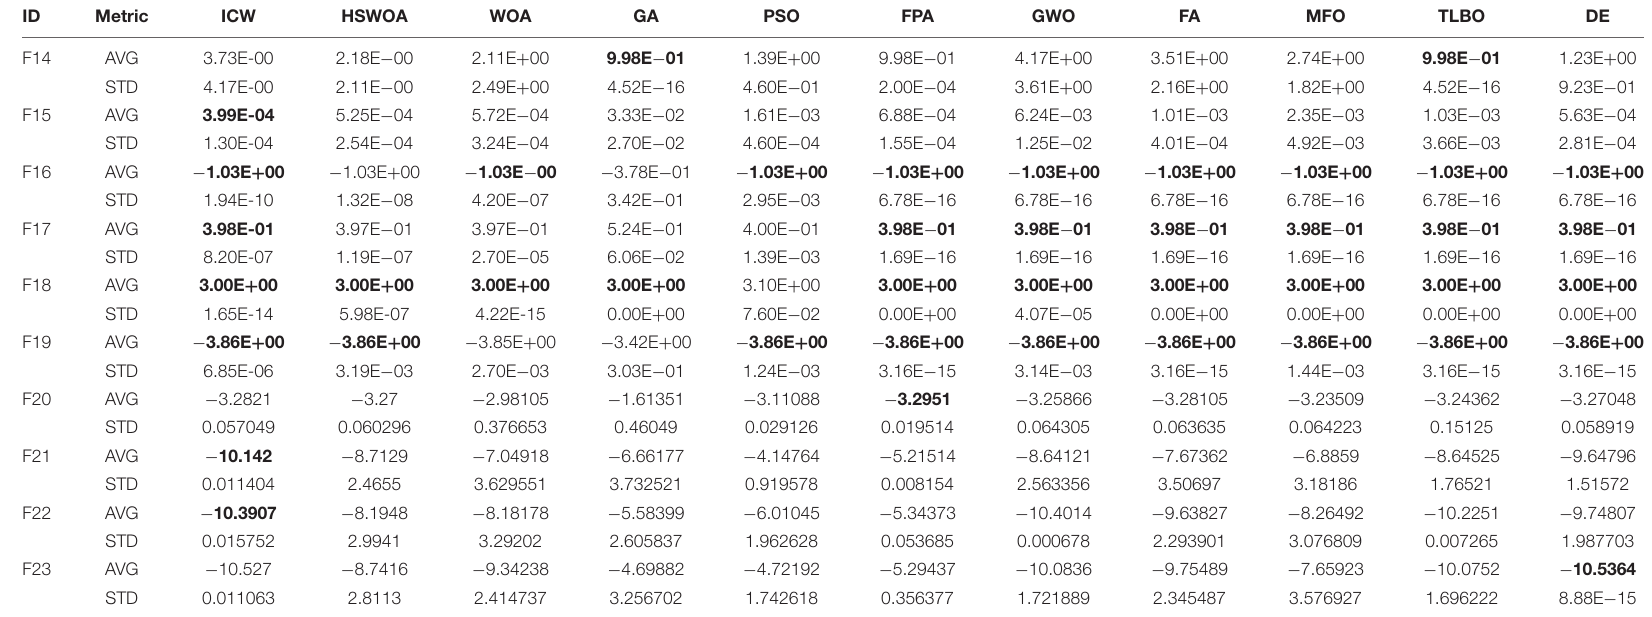
Bold values represent the optimal value of the function in the